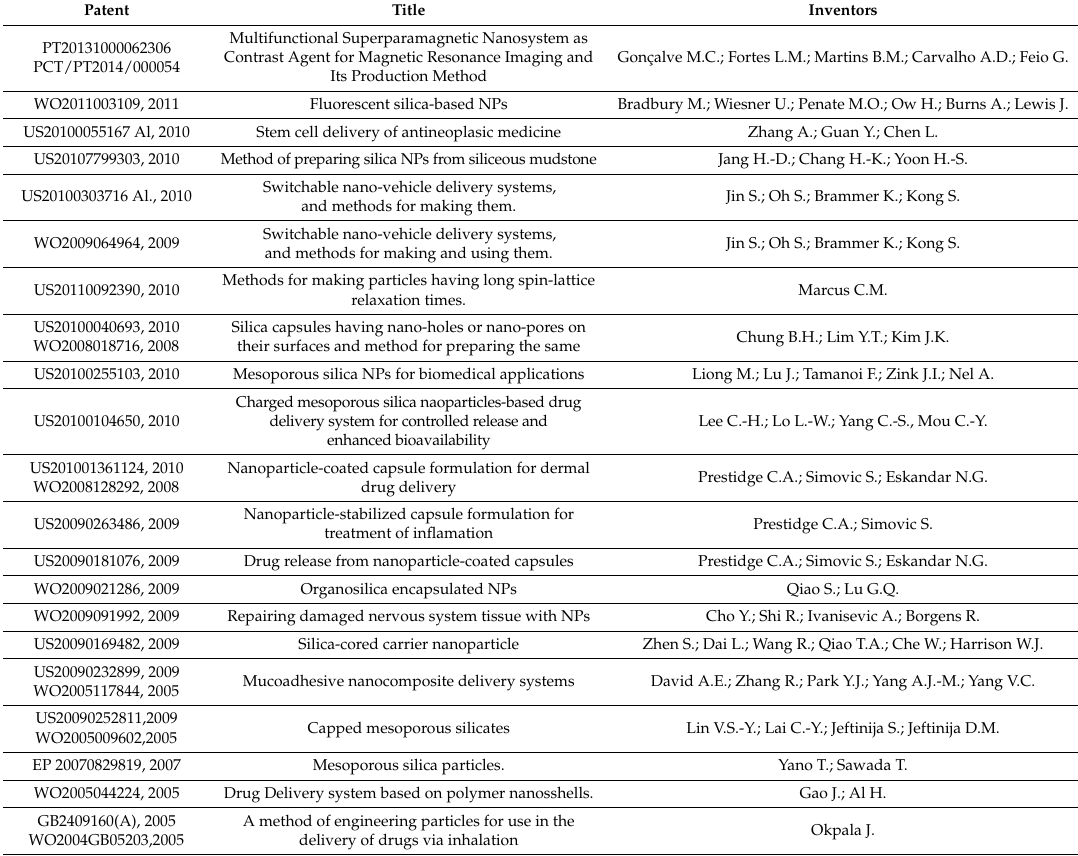
Table 3. Sol-gel silica-based NPs therapeutics recently patented (based on